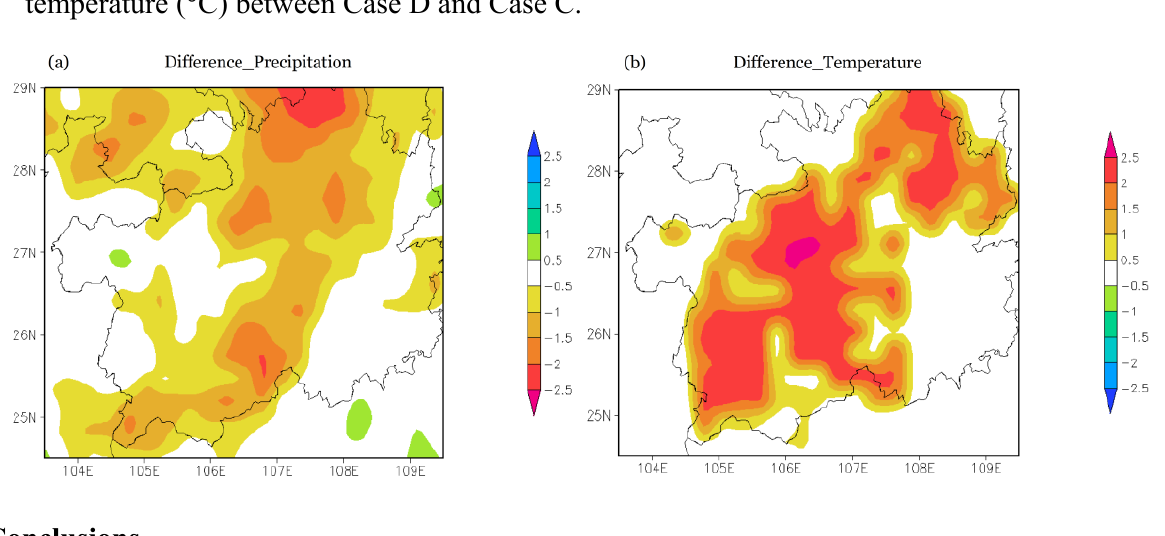
Figure 6. Ensemble mean differences in JJA ( a ) daily precipitation (mm); ( b ) surface temperature (°C) between Case D and Case